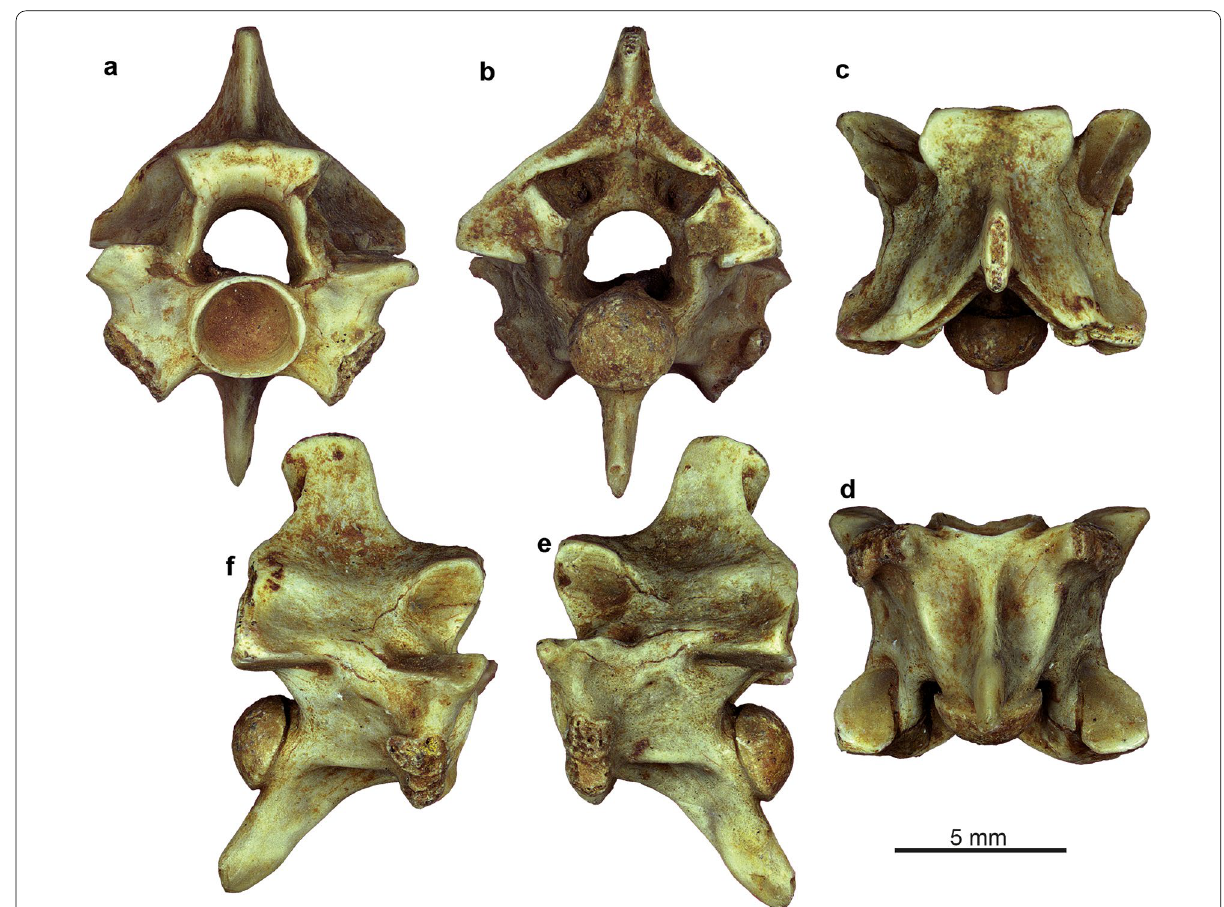
Fig. 77 Phosphoroboa filholii comb. nov. from an imprecisely known locality in the Phosphorites du Quercy: anterior trunk vertebra (NHMW 2019/0033/0119) in anterior ( a ), posterior ( b ), dorsal ( c ), ventral ( d ), left lateral ( e ), and right lateral ( f )